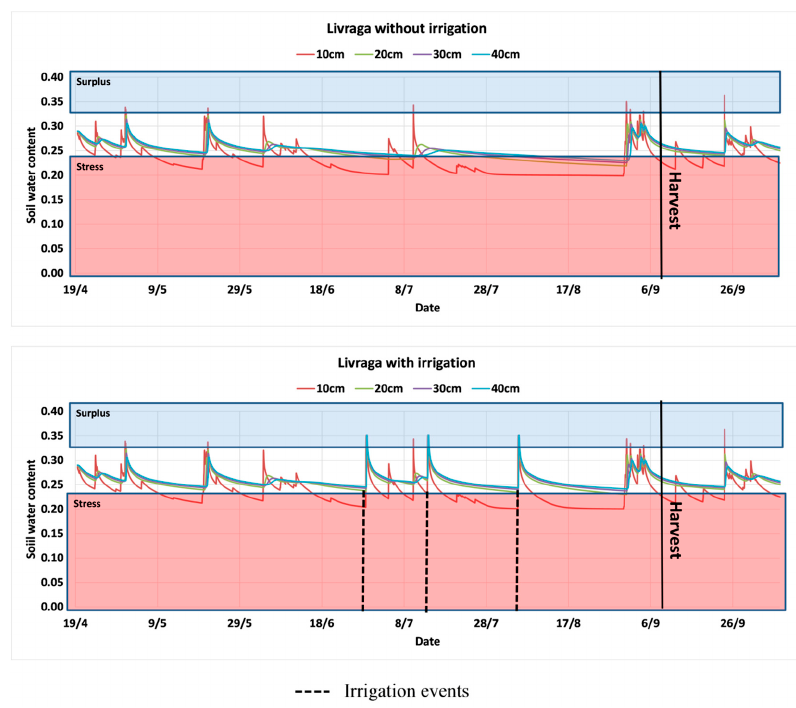
Figure 7. Soil moisture simulations of 2012 growing season in Livraga using Ross-VG model at different soil depth.